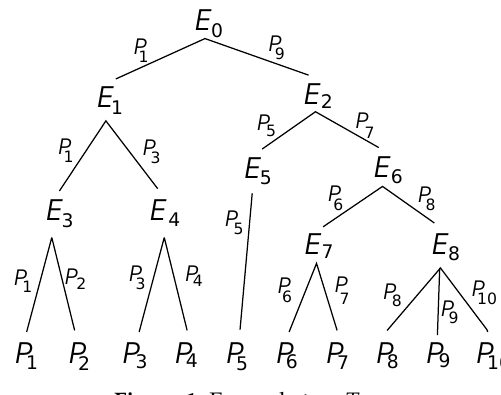
Figure 1. Example tree T ( 10,8 )